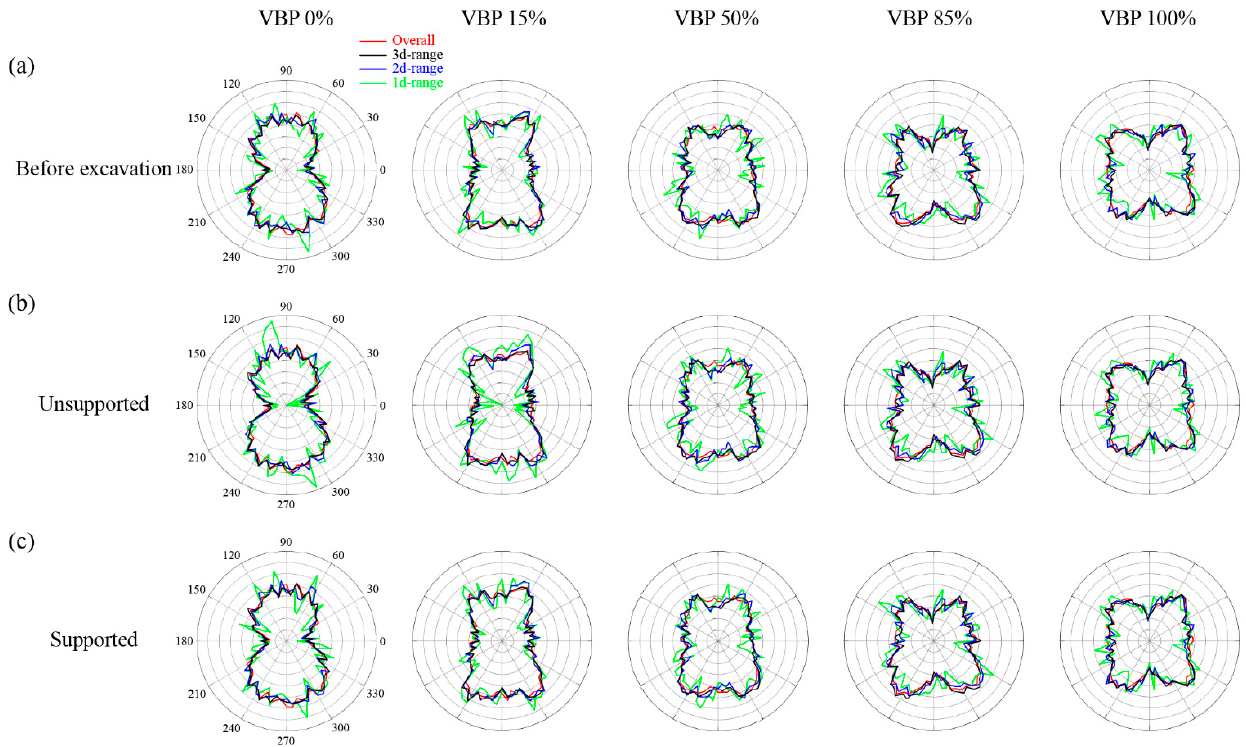
Figure 6. The proportion of the contact force in each direction in different groups: ( a ) before excava- tion, ( b ) unsupported excavation, and ( c ) supported